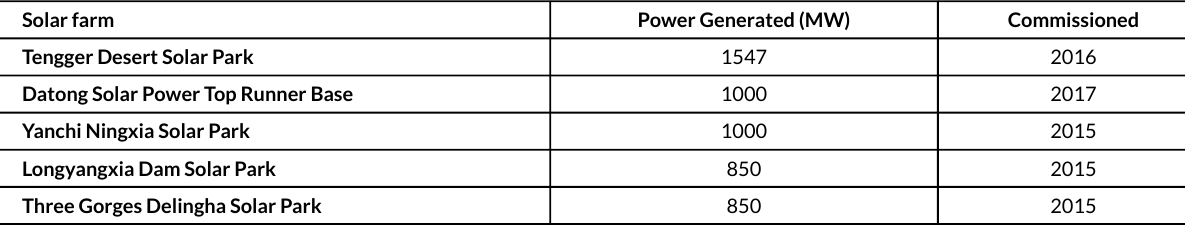
Table 5. The largest five solar farms in China